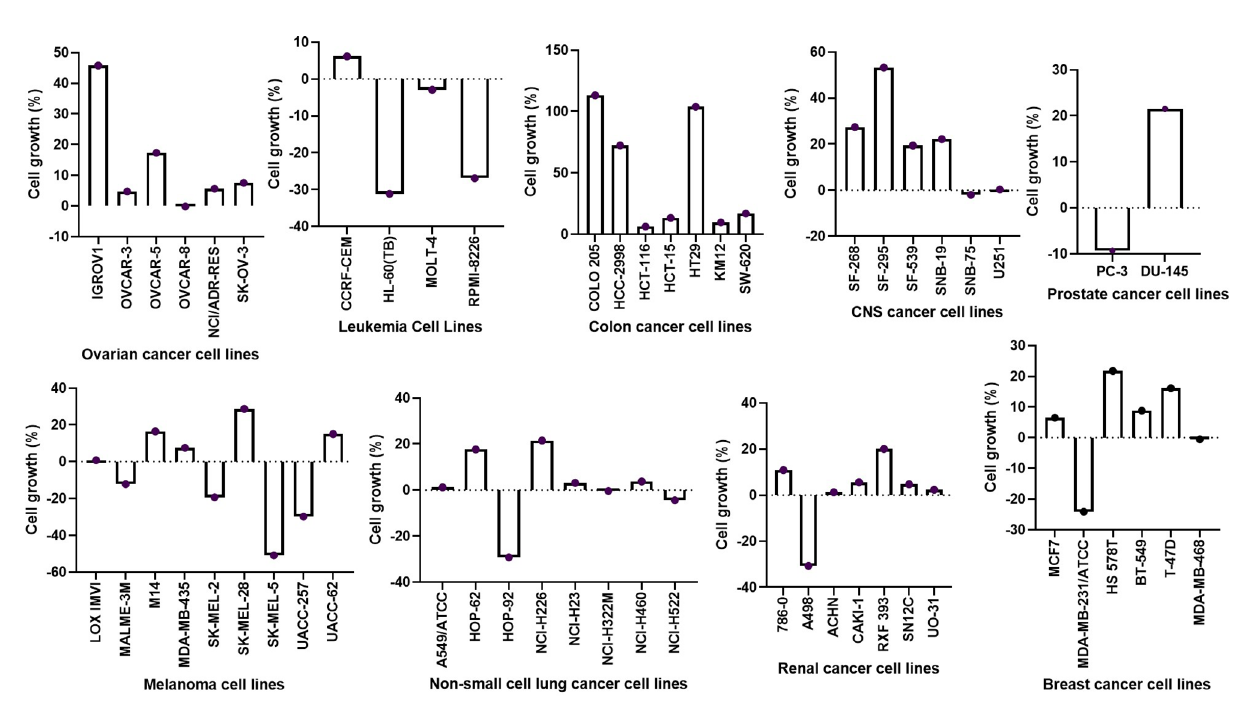
FIGURE 9 | Inhibitory activities of NSC765598 against panels of 60 human cancer cell lines. Each cell line was treated with a single dose of 10 m M of NSC765598 for 48 h. The bar points above point zero on the y-axis indicate the mean percentage of cell growth relative to cells without drug treatment, while bar points below point zero indicate the percentage of cell